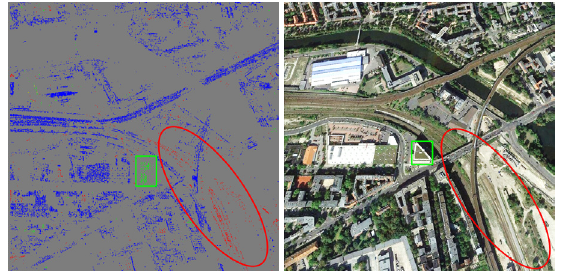
Figure 7. (a) Change detection image and (b) GE image (2014/09/05) for application of monitoring traffic infrastructures. Green area, new shoe shop. Red area, railway section under construction.